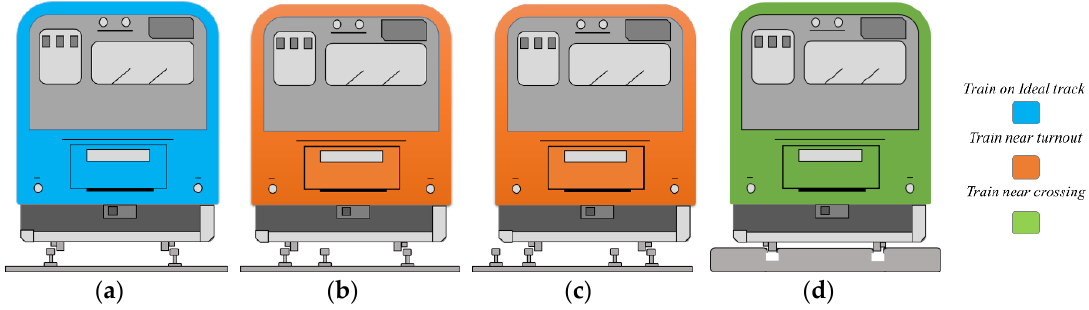
Figure 2. Rail track fastning: ( a ) ideal case, turnout ( b ) before changing the track and ( c ) after changing the track and ( d ) near rail crossing.